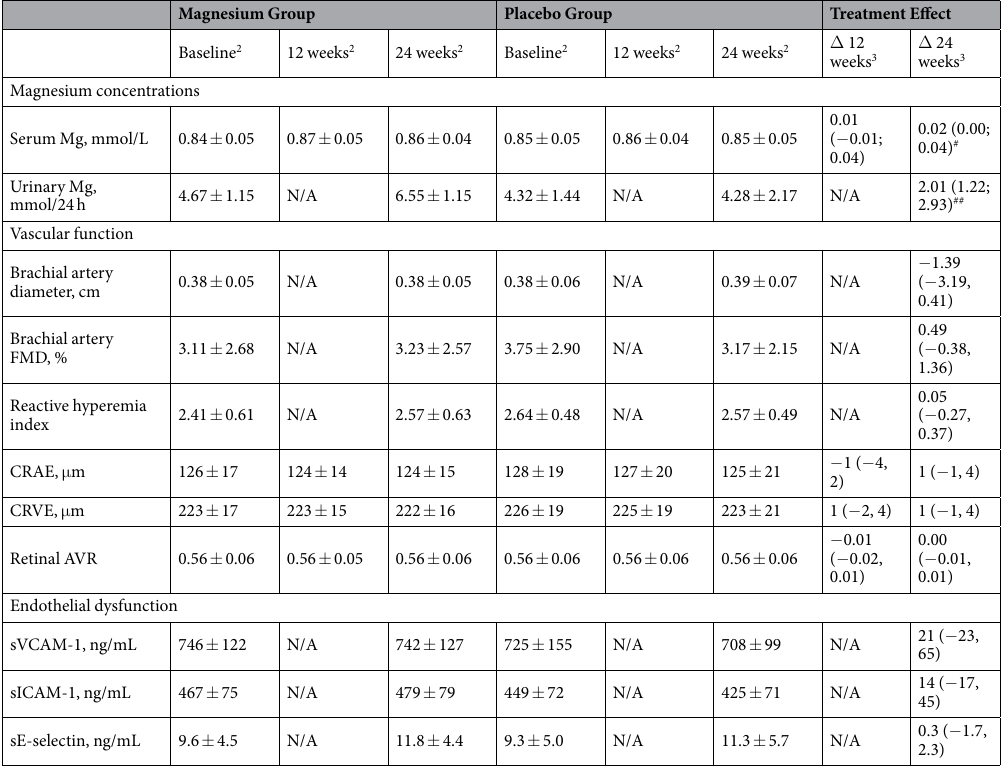
Table 1. Magnesium concentrations and vascular function measurements at baseline, and after a 12-week and 24-week magnesium or placebo treatment in a randomized controlled trial (RCT) with overweight and obese middle-aged and elderly adults 1 . 1 Magnesium group: n = 26; placebo group: n = 25. Mg: magnesium; FMD: flow-mediated vasodilation; CRAE: central retinal arteriolar equivalent; CRVE: central retinal venular equivalent; AVR: arteriolar-to-venular diameter ratio; sVCAM: soluble vascular cell adhesion molecule; sICAM: soluble intercellular adhesion molecule; sE-selectin: soluble endothelial selectin; N/A: not available. 2 Values are means ± SDs. 3 Values are mean changes (95% CI) obtained from a one-way ANCOVA with baseline value as covariate. Treatment effect: # P < 0.10, ## P <